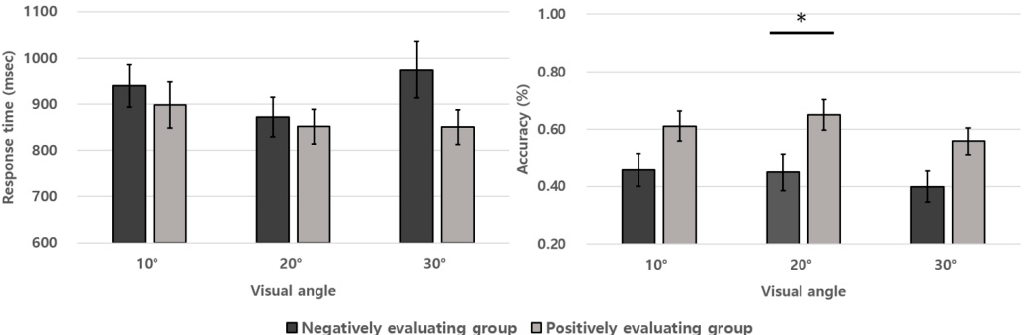
Figure 2. Response times and accuracy rates of two experimental groups in the performance of the UFOV task. Error bars represent the standard error. (* p < 0.05).